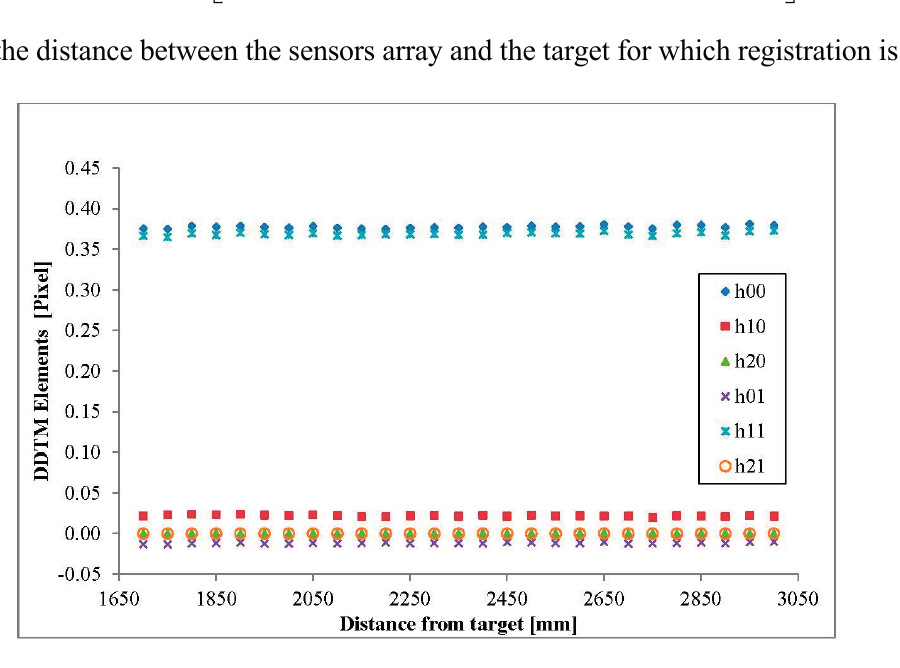
Figure 7. DDTM elements ( h 00 , h 10 , h 20 , h 01 , h 11 , h 21 ).